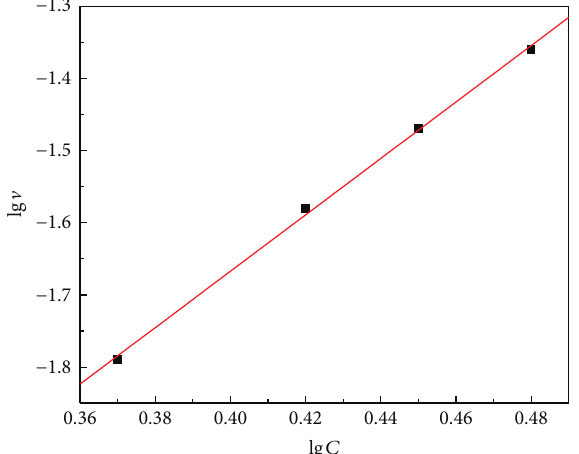
Figure 4: Relationship between lg V and lg 𝐶 (at 80 ∘ C).